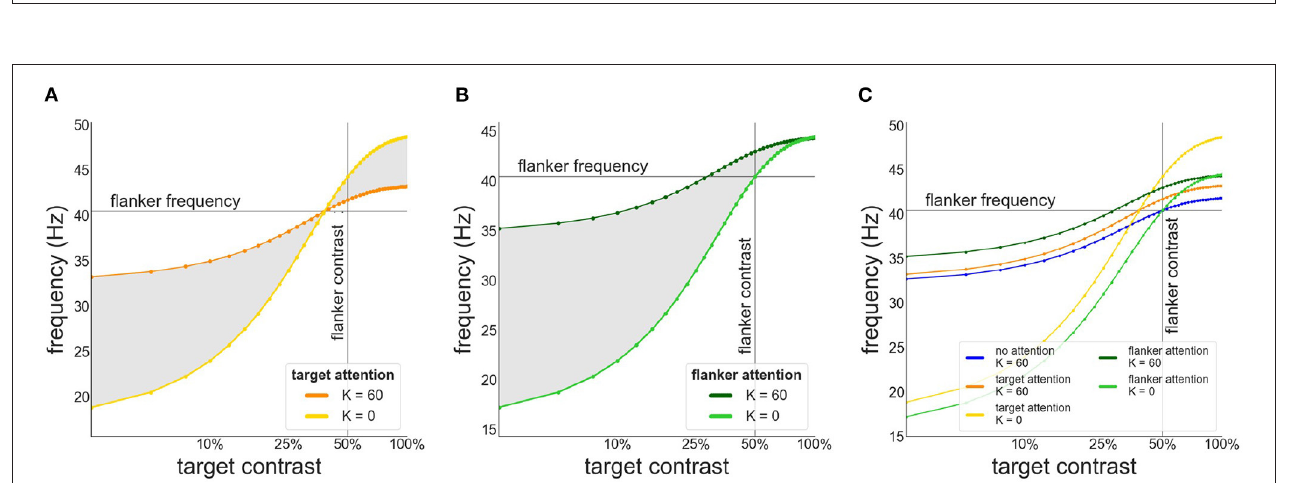
FIGURE 6 | Target frequency as a function of contrast in the presence of attention. (A) Attention directed toward the target. Frequency of target patch is shown in the absence (yellow) and presence of collinear (orange) flankers (B) Attention directed toward the flankers. Frequency of target patch in absence (light green) and presence (dark green) of collinear flankers. (C) Comparison of the target frequency for different attention configurations. Target frequency is shown without attention (blue) or when attention is directed toward the target (orange/yellow) or the flankers (green).